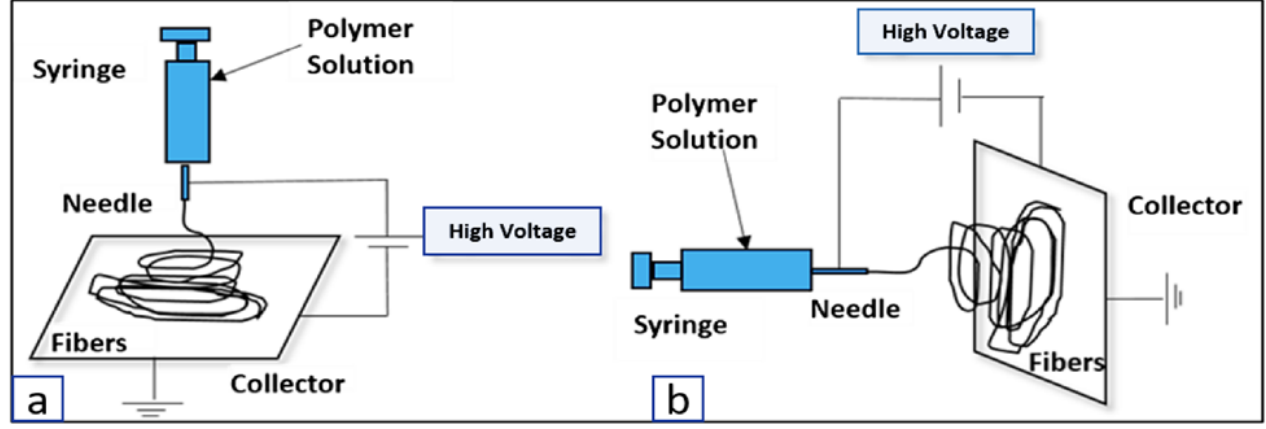
Figure 6. ( a ) Schematics of electrospinning apparatus of vertical setup and ( b ) horizontal setup Reproduced from ref. [46].